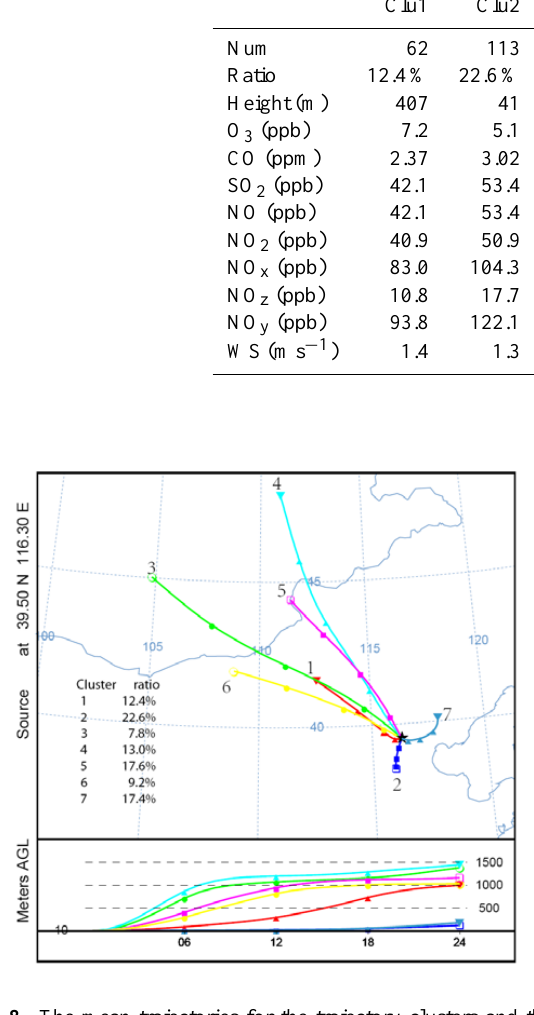
Fig. 8. The mean trajectories for the trajectory clusters and their ratios to the total number of trajectories